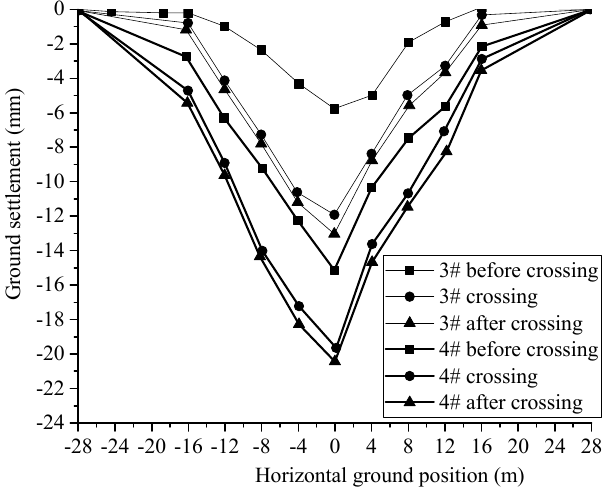
Figure 6. Horizontal ground settlement under the condition of first-up and then-down crossing.